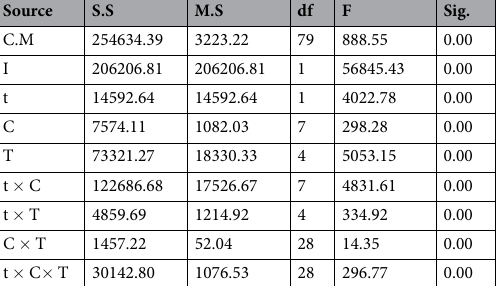
Table 8. Analysis of variance of the effect of mortality and hatching (%) versus concentration, replication and time. Whereas: S.S (Sum of square); M.S (Mean square); df (Degree of freedom); C.M (Corrected model); I (Intercept); t (Treatments); C (Concentration); T (Time); t × C (Treatment × Concentration); t × T (Treatment × Time); C × T (Concentration × Time); t × C × T (Treatment × Concentration ×